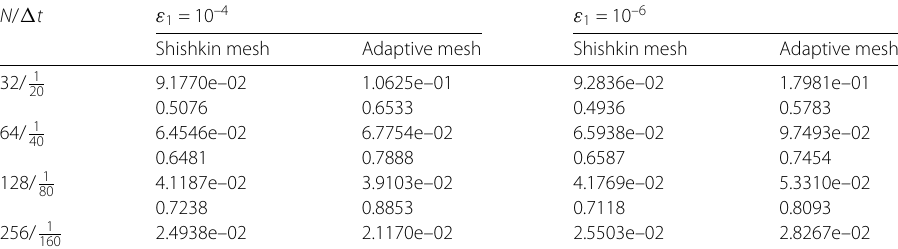
Table 10 Comparison of numerical results of Example 5.2 with Shishkin mesh with ε 2 = 10 –2